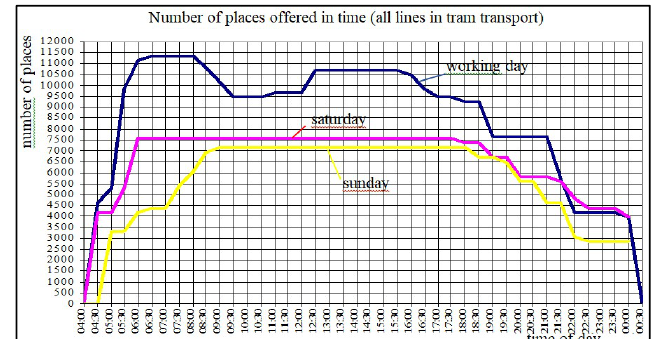
Figure 2. Supply service in the tram system (number of seats offered per hour on all lines)